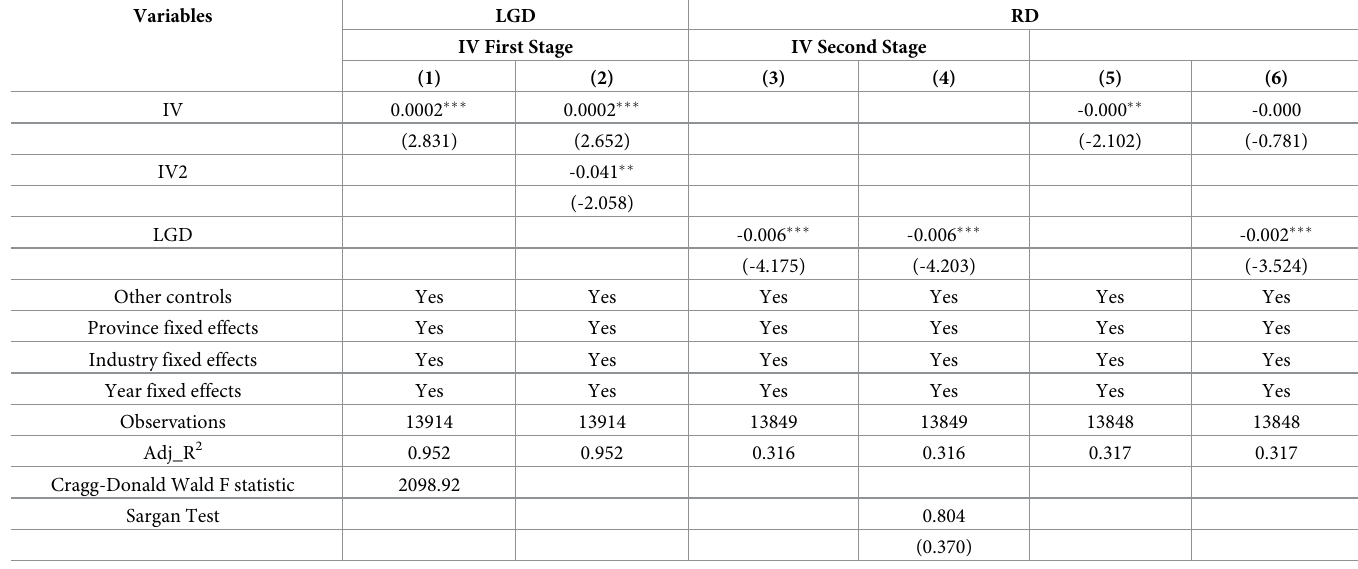
Table 4. Endogenous Test: IV